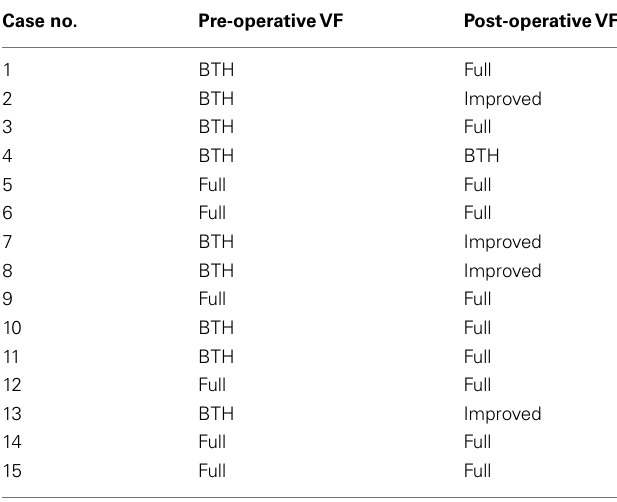
Table 3 |Visual field before and after the